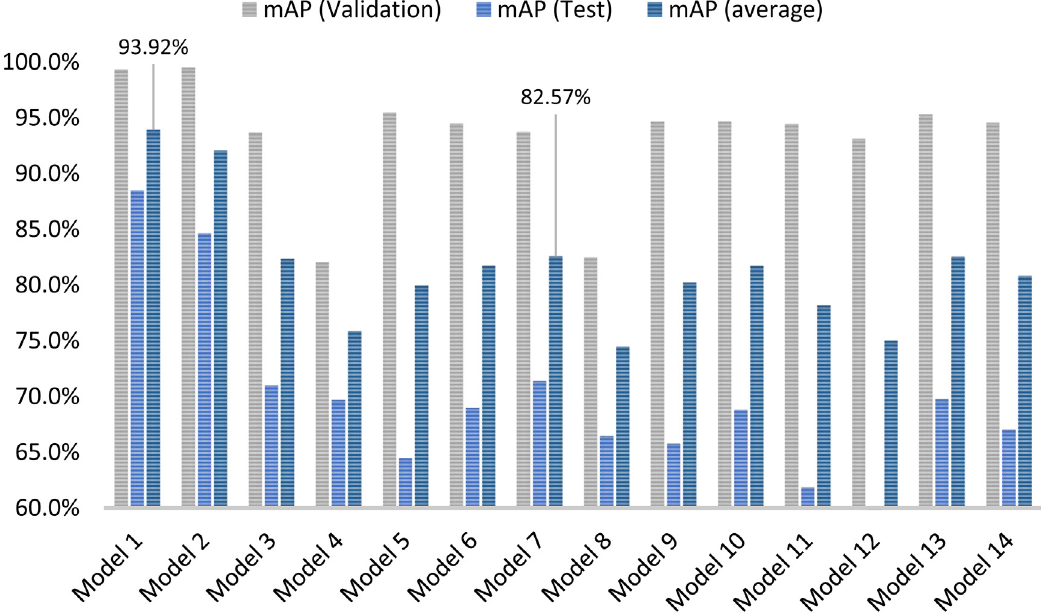
Fig. 6. The mAP values calculated from each model when performing single-class detection (dark region).